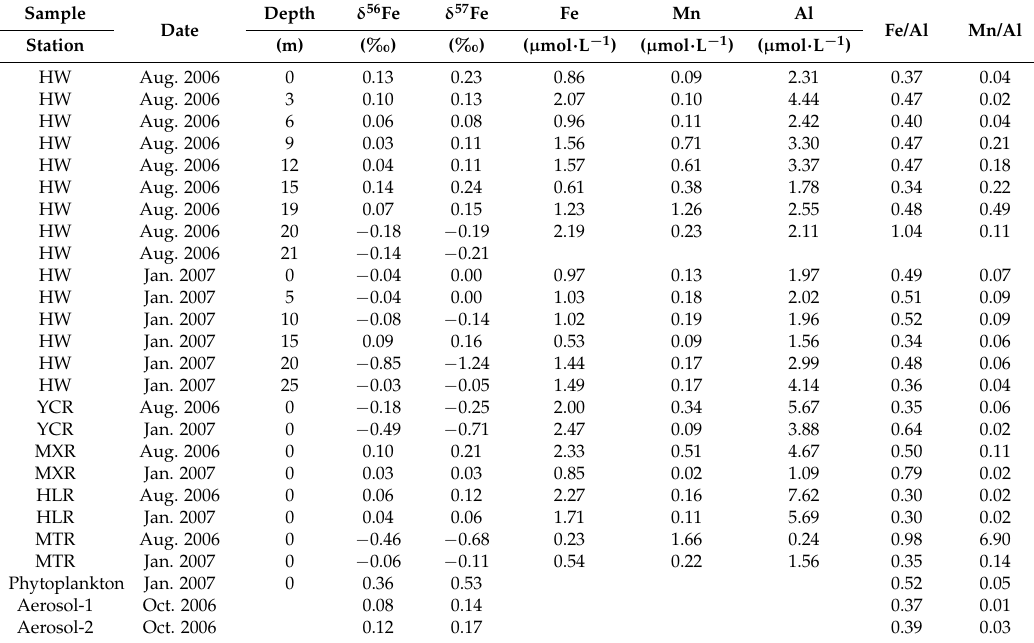
Table 3. Iron isotopic composition and chemical composition of trace ions Fe, Mn and Al of Hongfeng Lake and its inflowing